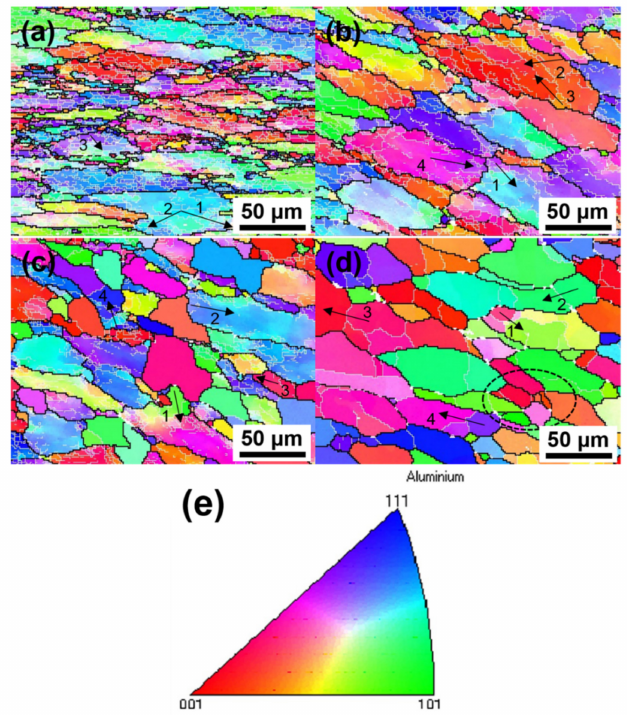
Figure 10. IPF images of the deformed microstructure of spray deposited 7055 aluminum al- loy under hot compression conditions of 300 ◦ C/0.001 s − 1 ( a ), 400 ◦ C/0.1 s − 1 ( b ), 450 ◦ C/5 s − 1 ( c ) and 450 ◦ C/0.001 s − 1 ( d ). ( e ) Representation of the color code used to identify the crystallographic orientation on a standard stereographic (Arrows 1, 2, 3 and 4 in each image are the misorientation cumulative